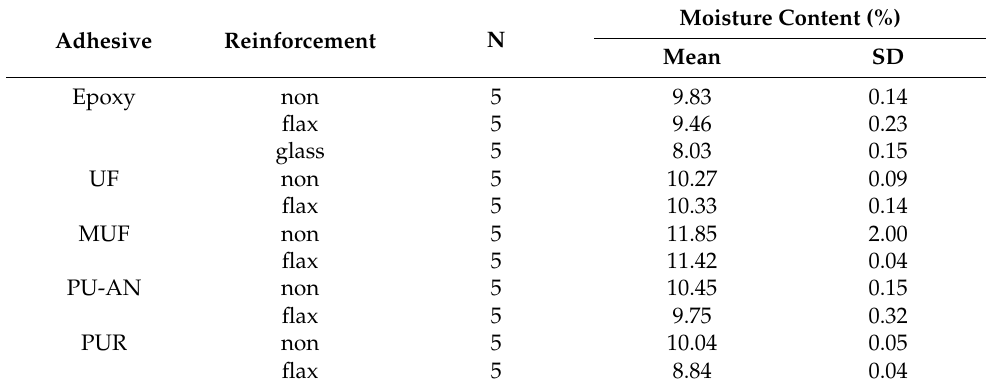
Table 3. Postproduction moisture